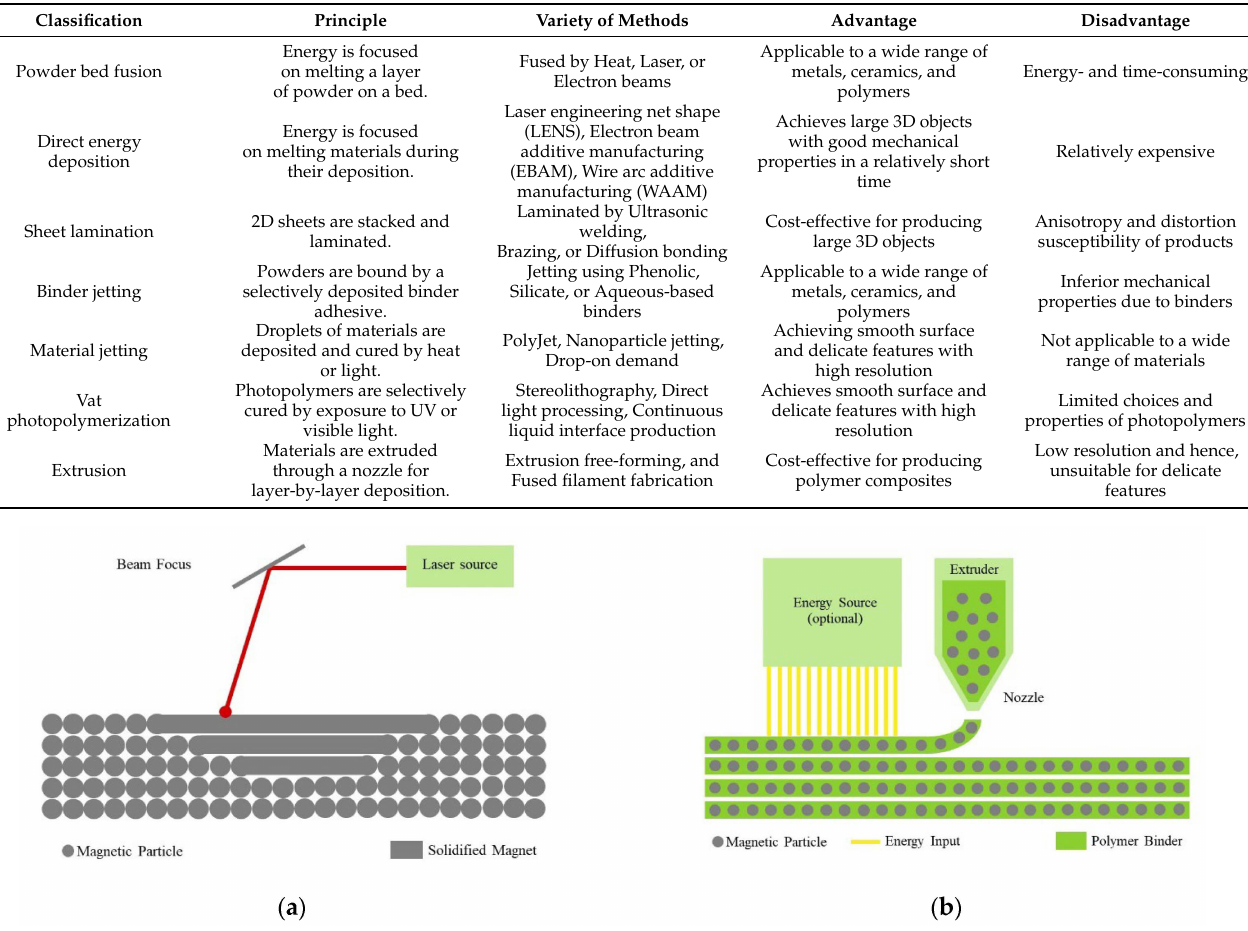
Table 1. Classification of 3D printing techniques.